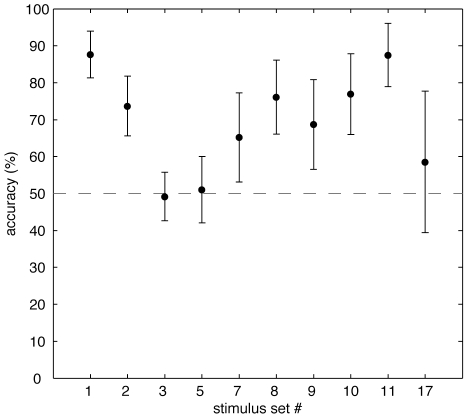
SVM performance.Mean Support Vector Machine prediction accuracy for the correct percepts is shown for the ten tested image sets. Accuracy over fixations of one subject was calculated using SVM's trained on the remaining fixation data of the ambiguous stimuli (leave-one-out cross validation). Errorbars depict SEM's.